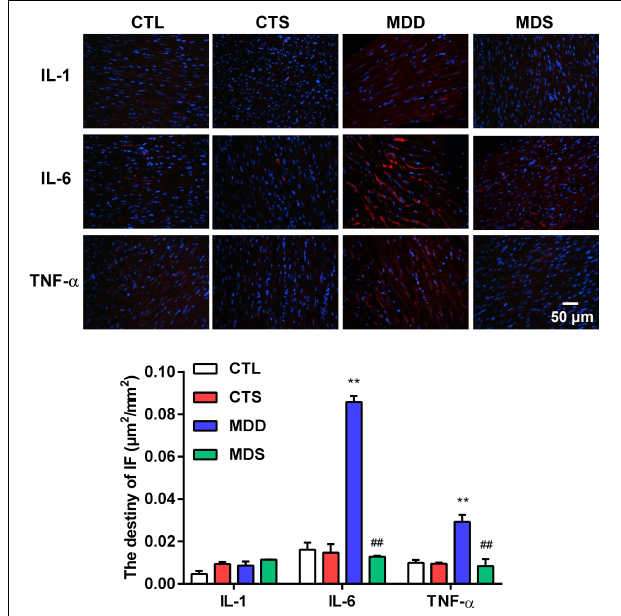
FIGURE 4 | Histological results for IL-1, IL-6, and TNF- α in four groups. Representative images of IL-1, IL-6, and TNF- α immunofluorescence staining (original magnification, 400 × ) of LA ( n = 5). Blue: Nucleus of cardiomyocyte; Red: IL-6 positive, IL-6 positive, TNF- α positive. The lower panel shows the statistical bars of IL-1, IL-6, and TNF- α MDD group. LA = left atrium. ∗∗ P < 0.01 vs. CTL group; ## P < 0.01 vs. MDD